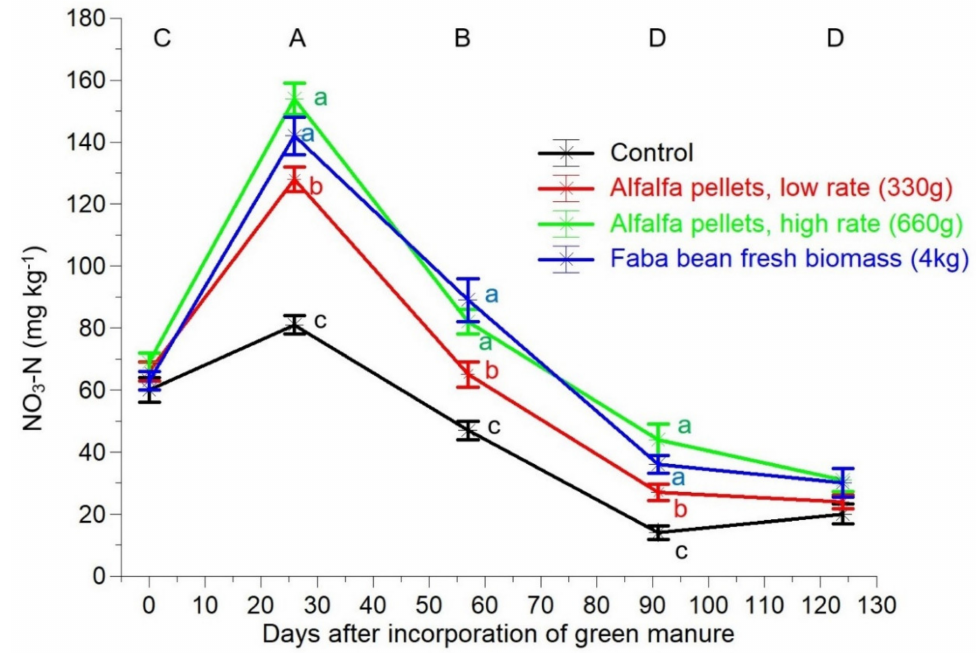
Figure 3. Soil NO 3 -N concentrations in an organic greenhouse crop of tomatoes as influenced by different treatments of mobile green manure. The vertical bars represent ± standard errors of means. The different lowercase and capital letters indicate significant differences between treatments and sampling dates, respectively, according to the Duncan’s multiple range test ( p <